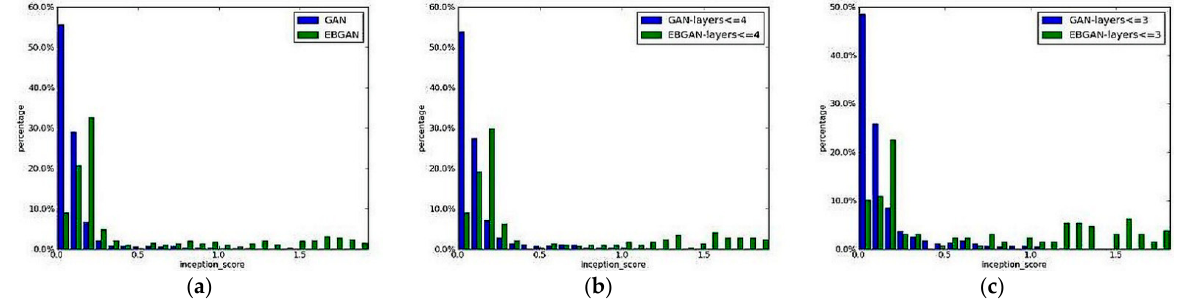
Figure 8. Comparison of Inception score vs. bin percentages for three different cases of GAN and EBGAN.